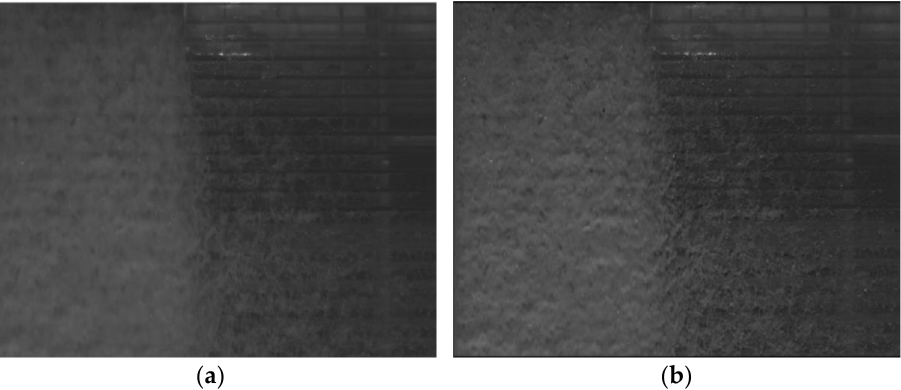
Figure 6. Frame 0001 corresponding to d c / h = 1.13 and 200 fps. ( a ) Original image. ( b ) Image after a CLAHE filter.